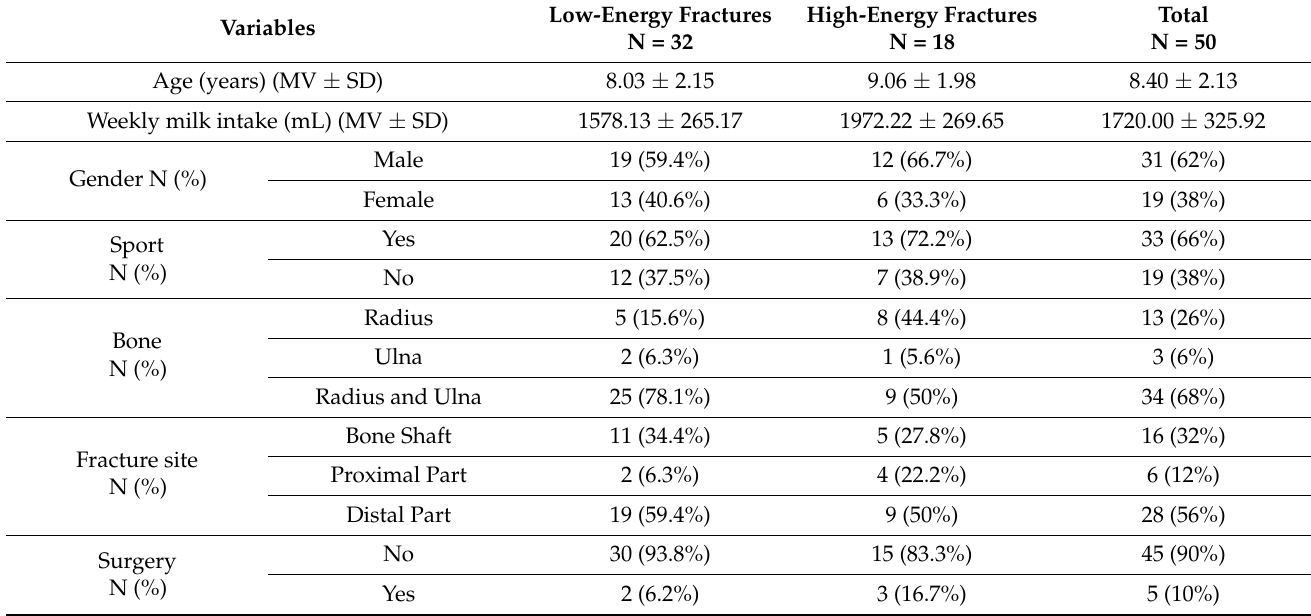
Table 1. General characteristics of the tested